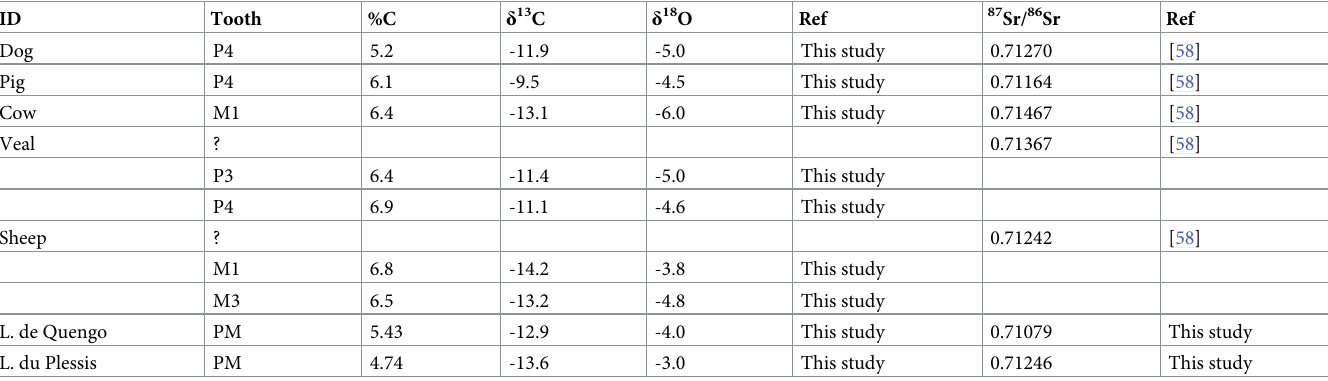
Table 3. Strontium, carbon and oxygen isotope values obtained in dental